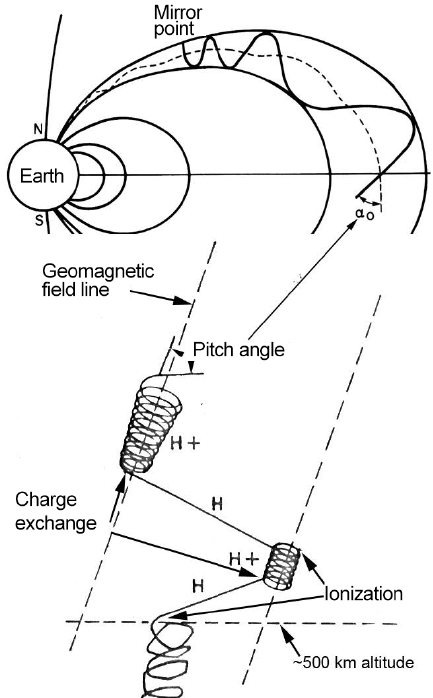
Figure 10. A cartoon representation where protons bombard the Earth’s atmosphere; multiple charge exchanges occur resulting in excited hydrogen atoms (H*) emissions followed by hydrogen emissions, new ionizations and charge exchanges. The production of hydrogen emissions mainly occurs below